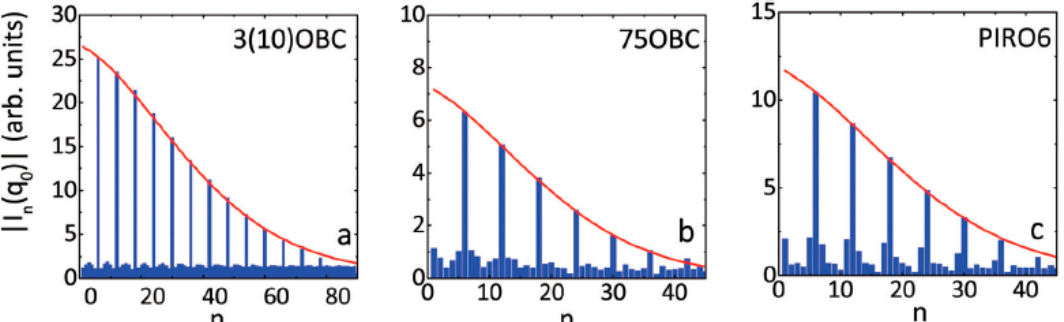
Figure 7. Magnitudes of the Fourier components |𝐼 (cid:3041) (𝑞 (cid:2868) )| as a function of the order number n for three different compounds: 3(10)OBC at the relative temperature Δ𝑇 = 𝑇 − 𝑇 (cid:3004) = −5.3 ℃ ( a ), 75OBC at Δ𝑇 = −4.55 ℃ ( b ) and PIRO6 at Δ𝑇 = −4.3 ℃ ( c ). The temperature Δ𝑇 is calculated relative to the respective temperature 𝑇 (cid:3004) of the second-order Sm-A–Hex-B phase transition for each compound. Red lines show fitting using the MCST (adopted from Zaluzhnyy et al. [17]––Published by The Royal Society of Chemistry). Used under CC-BY 3.0.